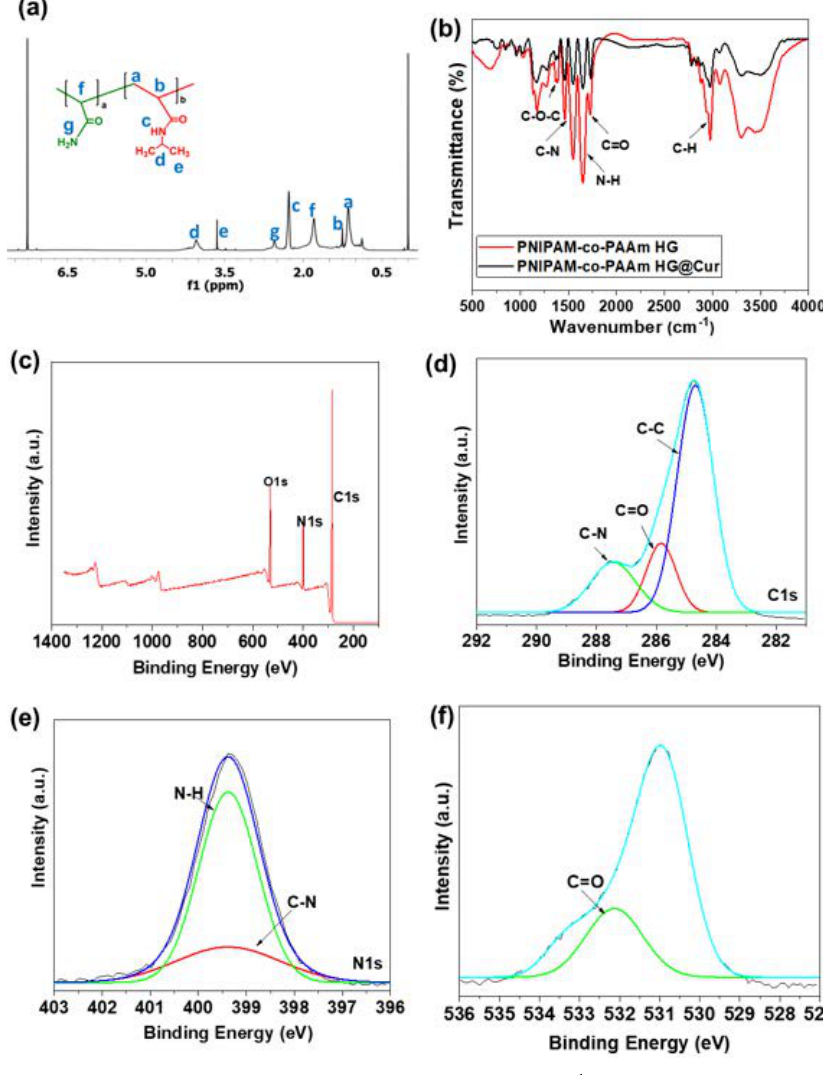
Figure 1. Characterization of PNIPAm-co-PAAm HG. ( a ) 1 H NMR spectrum of PNIPAm-co-PAAm HG. ( b ) FT-IR analysis of PNIPAm-co-PAAm HG without and with Cur. XPS analysis of PNIPAm-co- PAAm HG with ( c ) wide-scan, and core level spectra of ( d ) C 1s; ( e ) N 1s; and ( f ) O